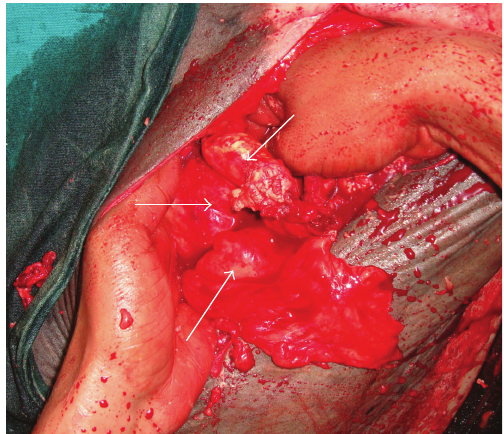
Figure 1: Liposarcoma growths (arrows) in omentum detected after laparotomy in a Holstein-Friesian crossbred